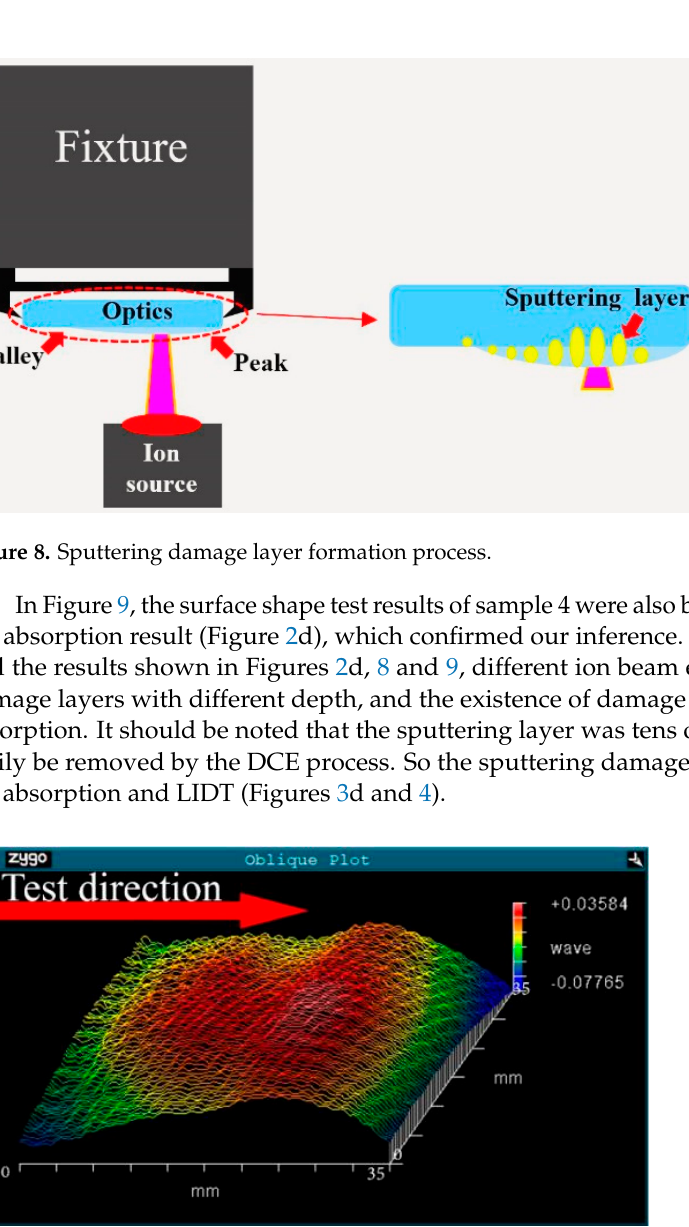
Figure 9. Surface shape test result.